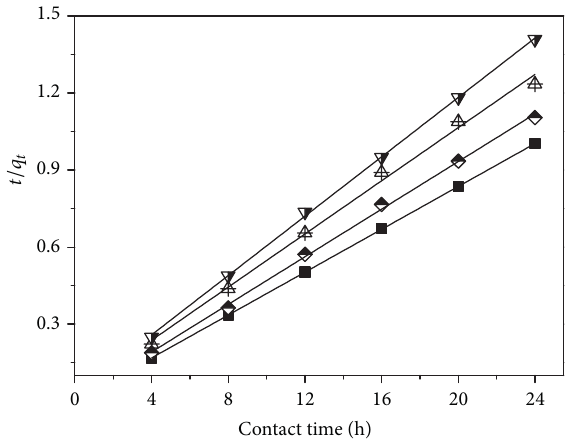
Figure 1: The plot of adsorption capacity of strontium ions on samples A (solid square), B (half-filled diamond), C (center up triangle), and D (half-filled down triangle) versus contact time; the concentration of aqueous SrCl 2 solution was 0.004 mol/L at 65 ∘ C and pH 10.